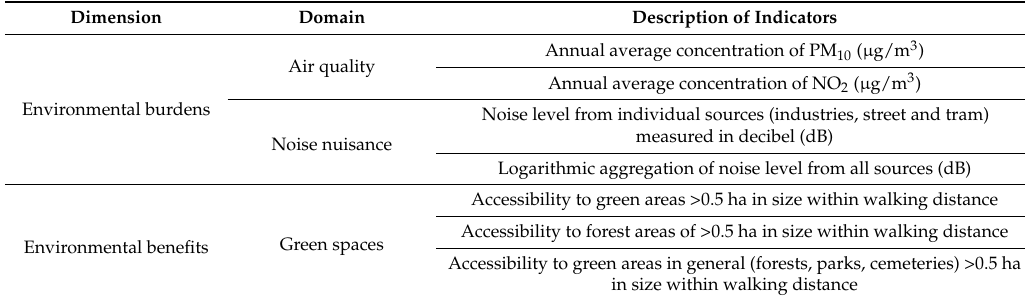
Table 1. Environmental indicators included in the index of multiple environmental burdens and benefits.